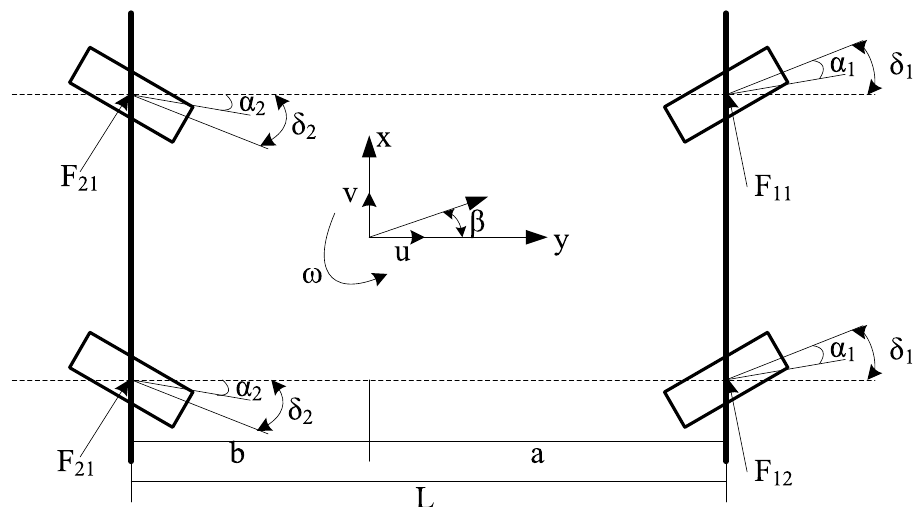
Fig. 3. The motion model of the two-degree-of-freedom forklift with four-wheel